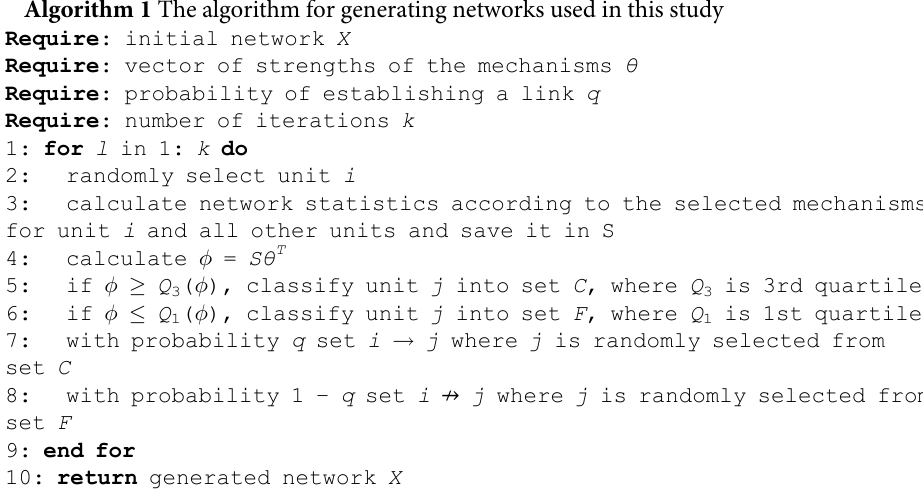
Algorithm 1 The algorithm for generating networks used in this